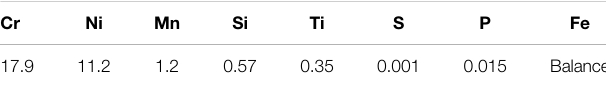
TABLE 1 | Chemistry composition of F321 austenitic stainless steel (wt%).